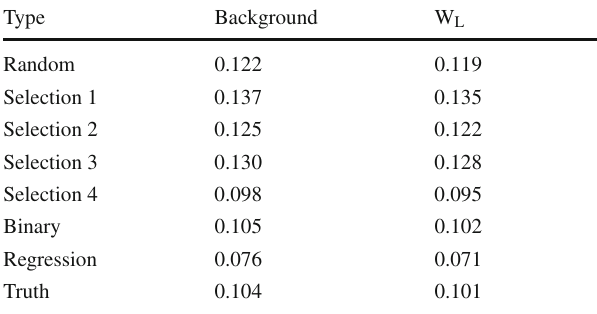
Table 3 Summary of the longitudinal polarization fraction extraction from the fit of the background and longitudinal (W L ) distributions to the full computation. The background is defined as the difference between the full computation with an unpolarized W boson and with non-resonant production modes included (Full comp.) and the longitu- dinal (W L ) contribution. The best fit value, for all the reconstruction methods, matches the truth polarization fraction, σ L /σ full = 0 . 257, within the sub-percent level. CI widths at the 95 % CL for background and longitudinal polarization fraction are reported. The numbers are obtained at 139.0 fb − 1 luminosity, which is the value of the